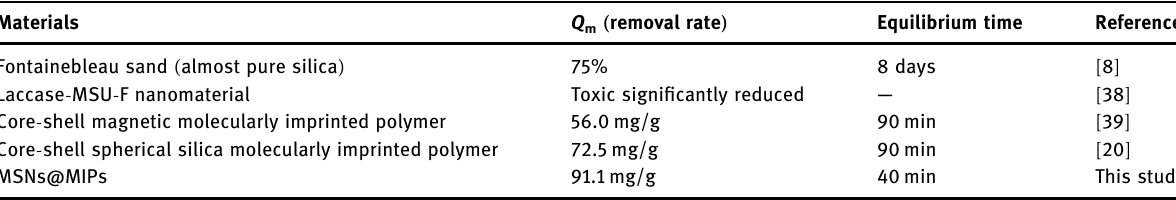
Table 3: Removal of dichlorophen by di ff erent materials Materials